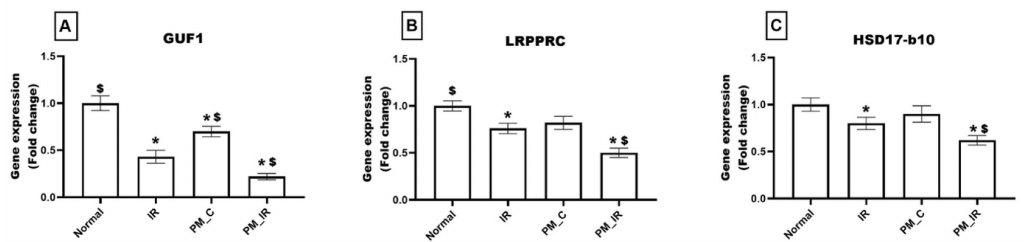
Figure 7. mRNA expression changes of ( A ) GUF1, ( B ) LRPPRC, and ( C ) HSD17-b10 in the my- ocardium. Values are mean ± SD. Significant difference from control group is indicated by asterisk (* p < 0.05, $ p < 0.05 vs. IR control). [Groups: (1) Normal, (2) IR, (3) PM_C, (4) PM_IR].